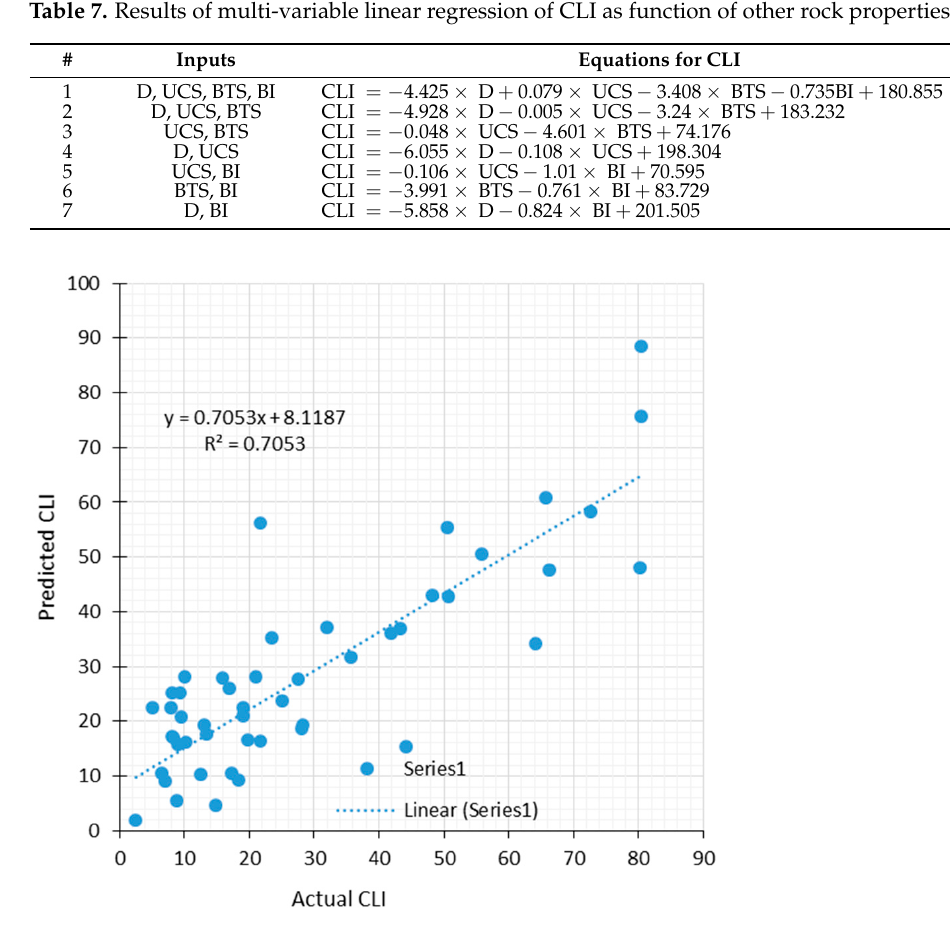
Figure 10. Relations between the measured CLI and predicted CLI for training (model 1 ‐ MLRM).